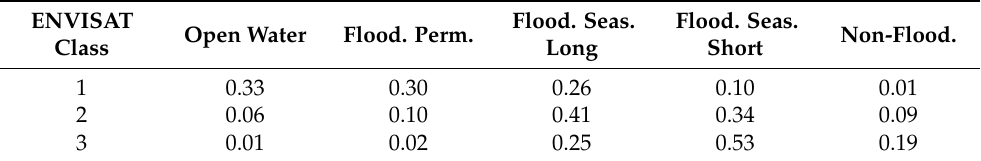
Table A1. Confusion matrix between 3 classes of RA backscattering coefficients from ENVISAT and the 5 land type classes identified on the study sites.